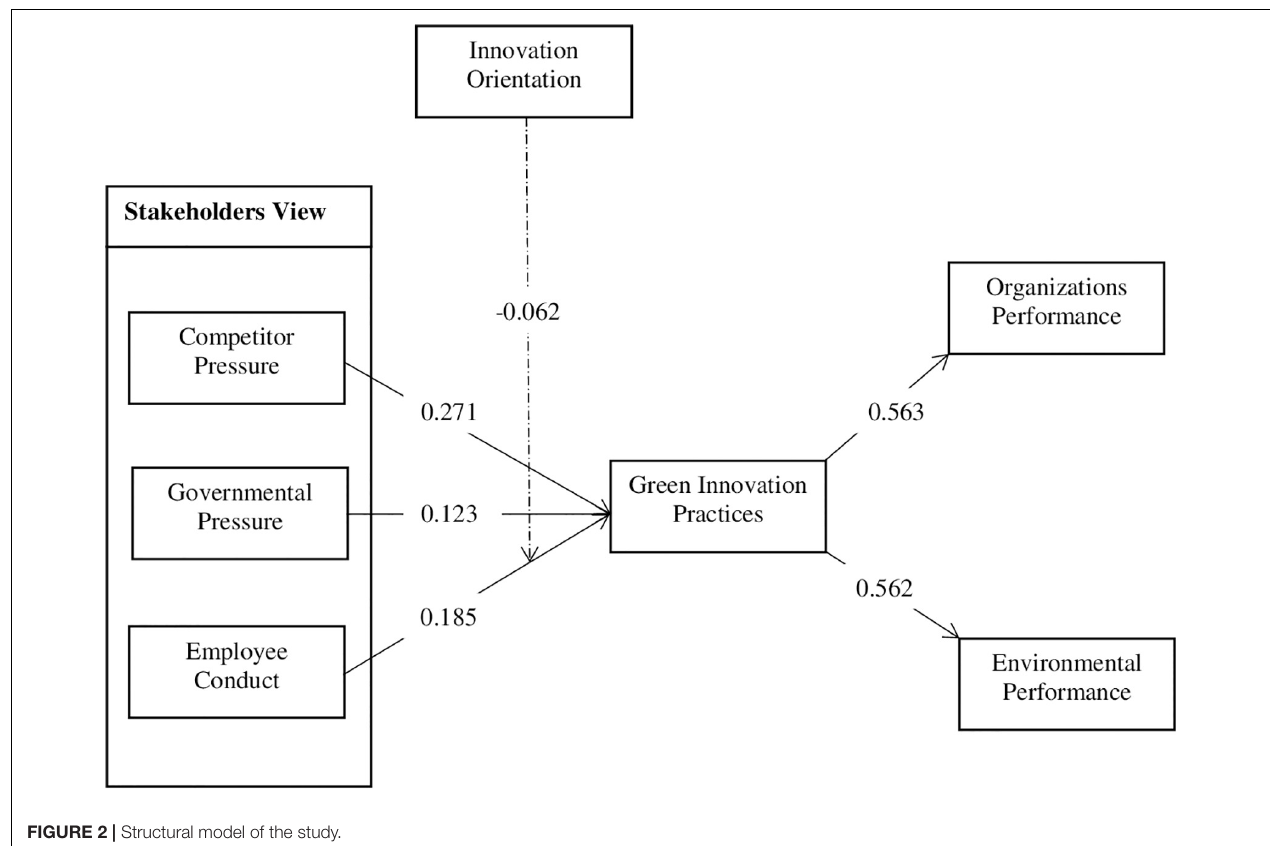
FIGURE 2 | Structural model of the study.